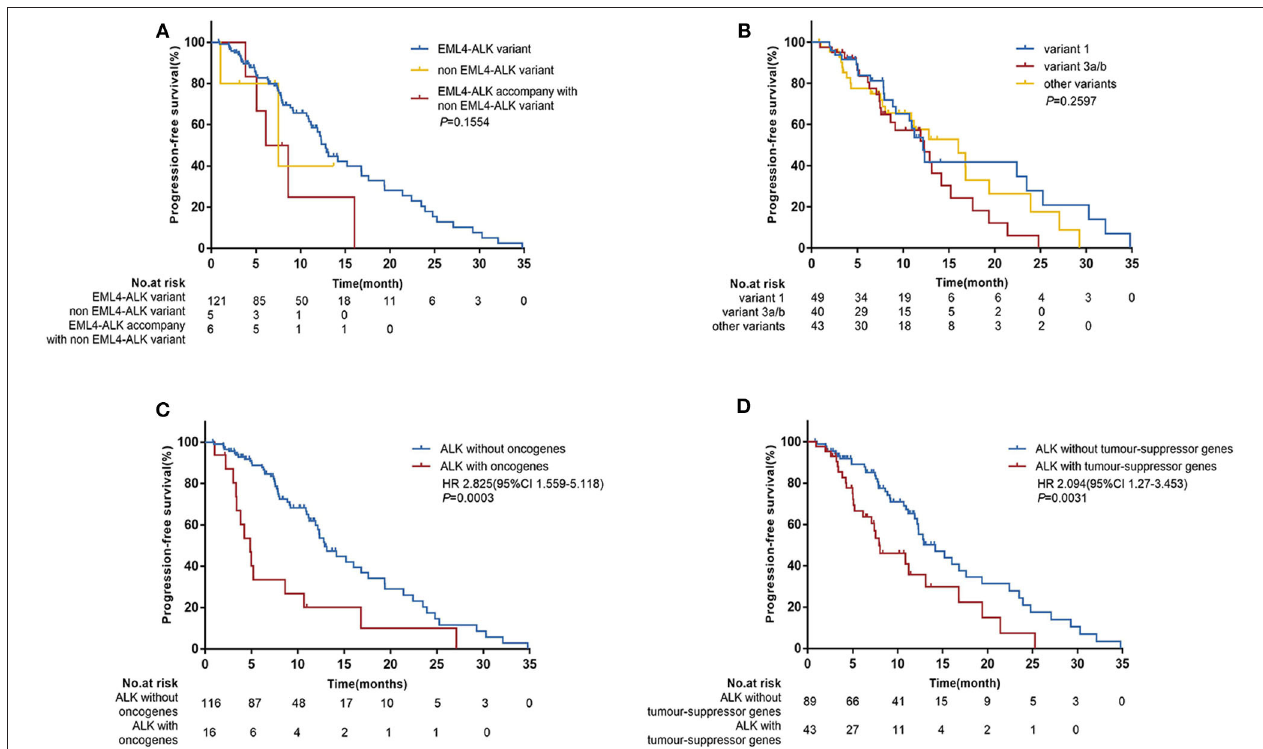
FIGURE 2 | Progression-free survival (PFS) according to baseline next-generation sequencing (NGS) data. (A) Patients were categorized into three subgroups: EML4- ALK rearrangements ( n = 121), non-EML4- ALK rearrangements ( n = 5), and EML4- ALK rearrangements accompanied by non-EML4- ALK rearrangements ( n = 6). (B) Patients with different EML4- ALK variants: variant 1 ( n = 49), variant 3a/b ( n = 40), and other variants ( n = 43). (C) Patients with oncogene mutations ( n = 16) vs. patients without oncogene mutations ( n = 116). (D) Patients with tumor-suppressor gene mutations ( n = 43) vs. patients without tumor-suppressor gene mutations ( n = 89). HR, hazard ratios; CI, confidence interval; p -values were calculated using the log-rank